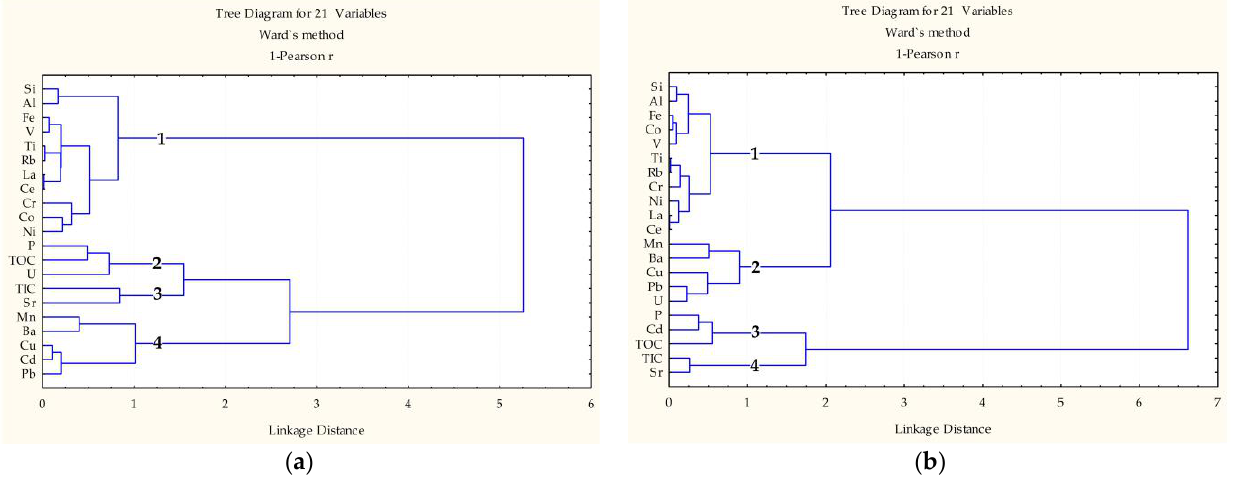
Figure 5. Cluster tree diagram for elements and major phase in the SPM of ( a ) the Norwegian Sea and ( b ) the Barents Sea.